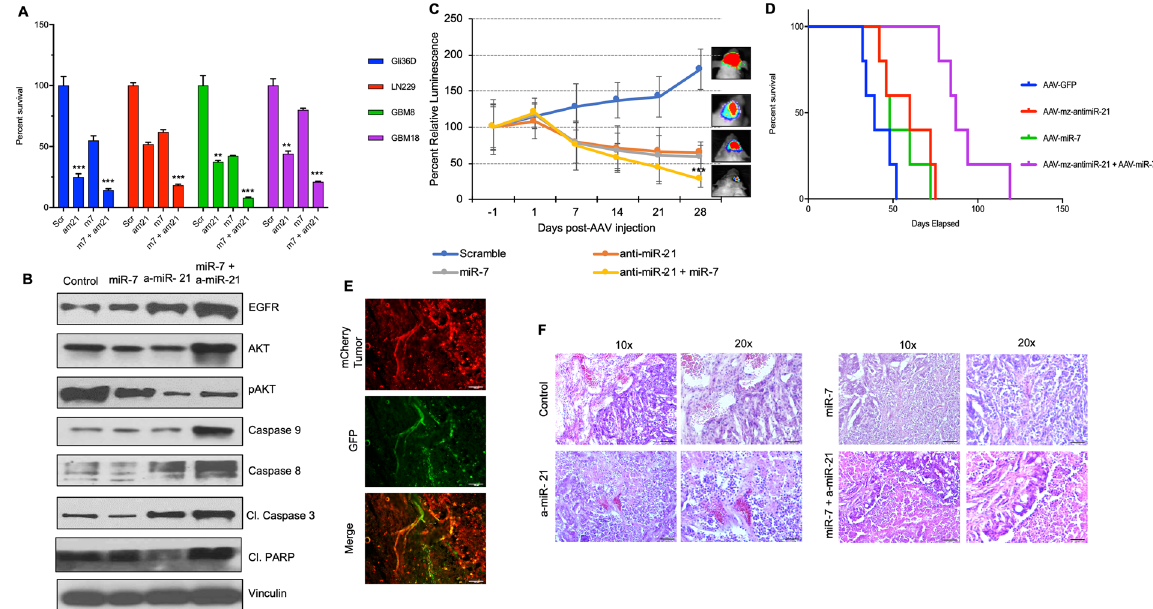
Figure 4. Combination of AAV delivered anti-miR-21 and miR-7 prolongs survival of mice bearing patient derived GBM xenografts. ( A ) Plot showing changes in viability of various GBM cells following combination treatment with AAV-miR-7 and AAV-miRzip-21. ( B ) Western blot analysis showing changes in various cell proliferation and death markers following treatment with AAV-miR-7 and AAV-miRzip-21. ( C ) Plot showing changes in tumor volumes of GBM-18-FmC overtime following AAV-miR-7 and AAV- miRzip-21 injections as compared to controls. ( D ) Kaplan-Meier survival curves following AAV-miR-7 and AAV-miRzip-21 injections as compared to controls. ( E ) Photomicrographs showing AAV-GFP infection of GBM tumors at day 4 post AAV injection. ( F ) H&E staining showing changes in tumor burden following a combination treatment of AAV delivered miR-7 and anti-miR-21. Data are presented as mean ± SEM. *** (P < 0.001), ** (P < 0.01) and * (P < 0.05). Scale bars represent 100